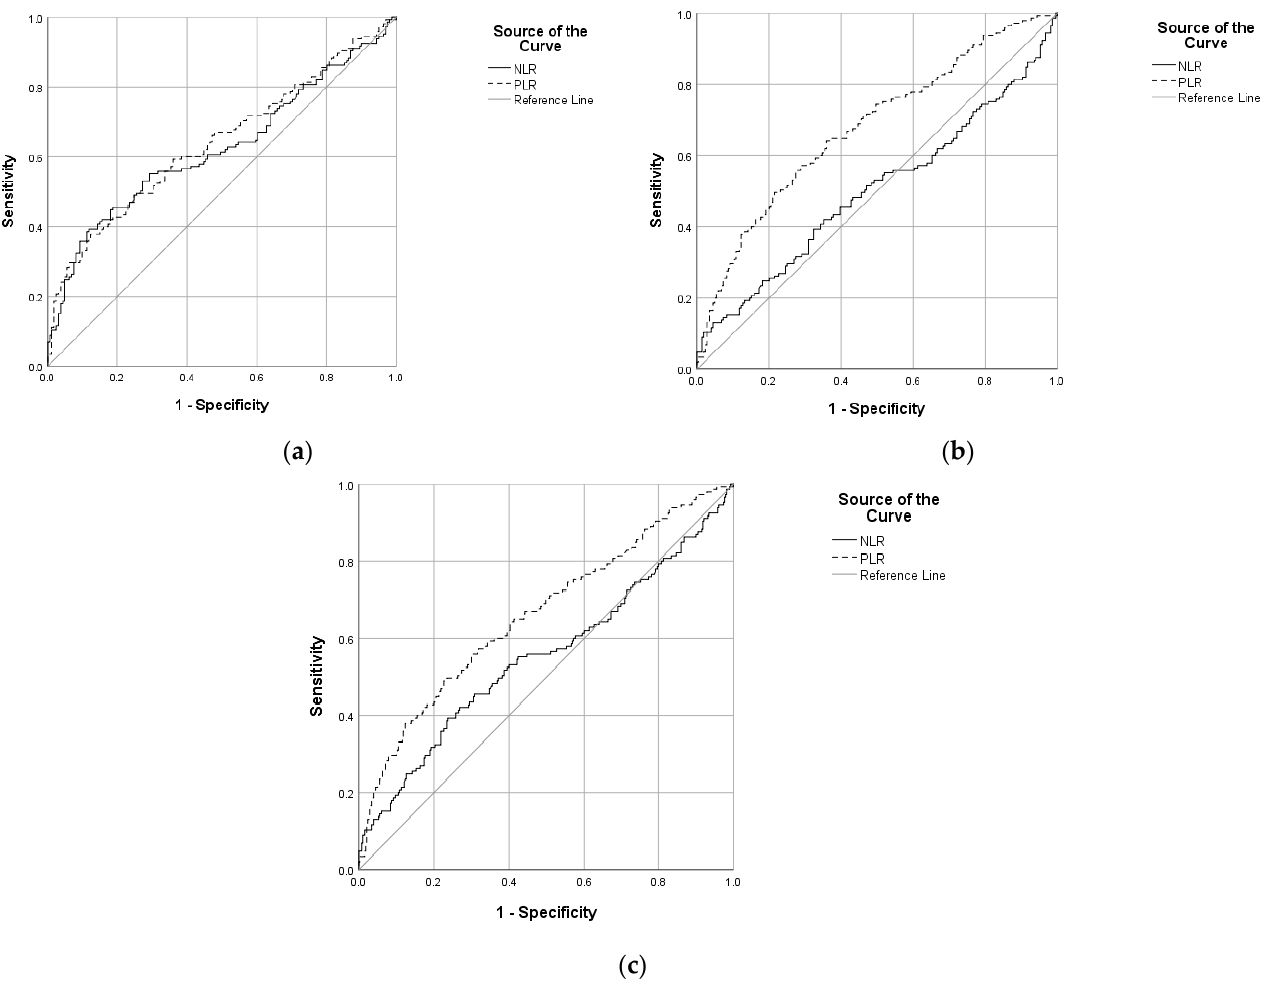
Figure 1. ROC curve with PLR and NLR ( a ) comparing COVID-19 group versus control group; ( b ) comparing COVID-19 group versus chronic respiratory disease group; ( c ) comparing COVID-19 group versus control group and chronic respiratory disease group.